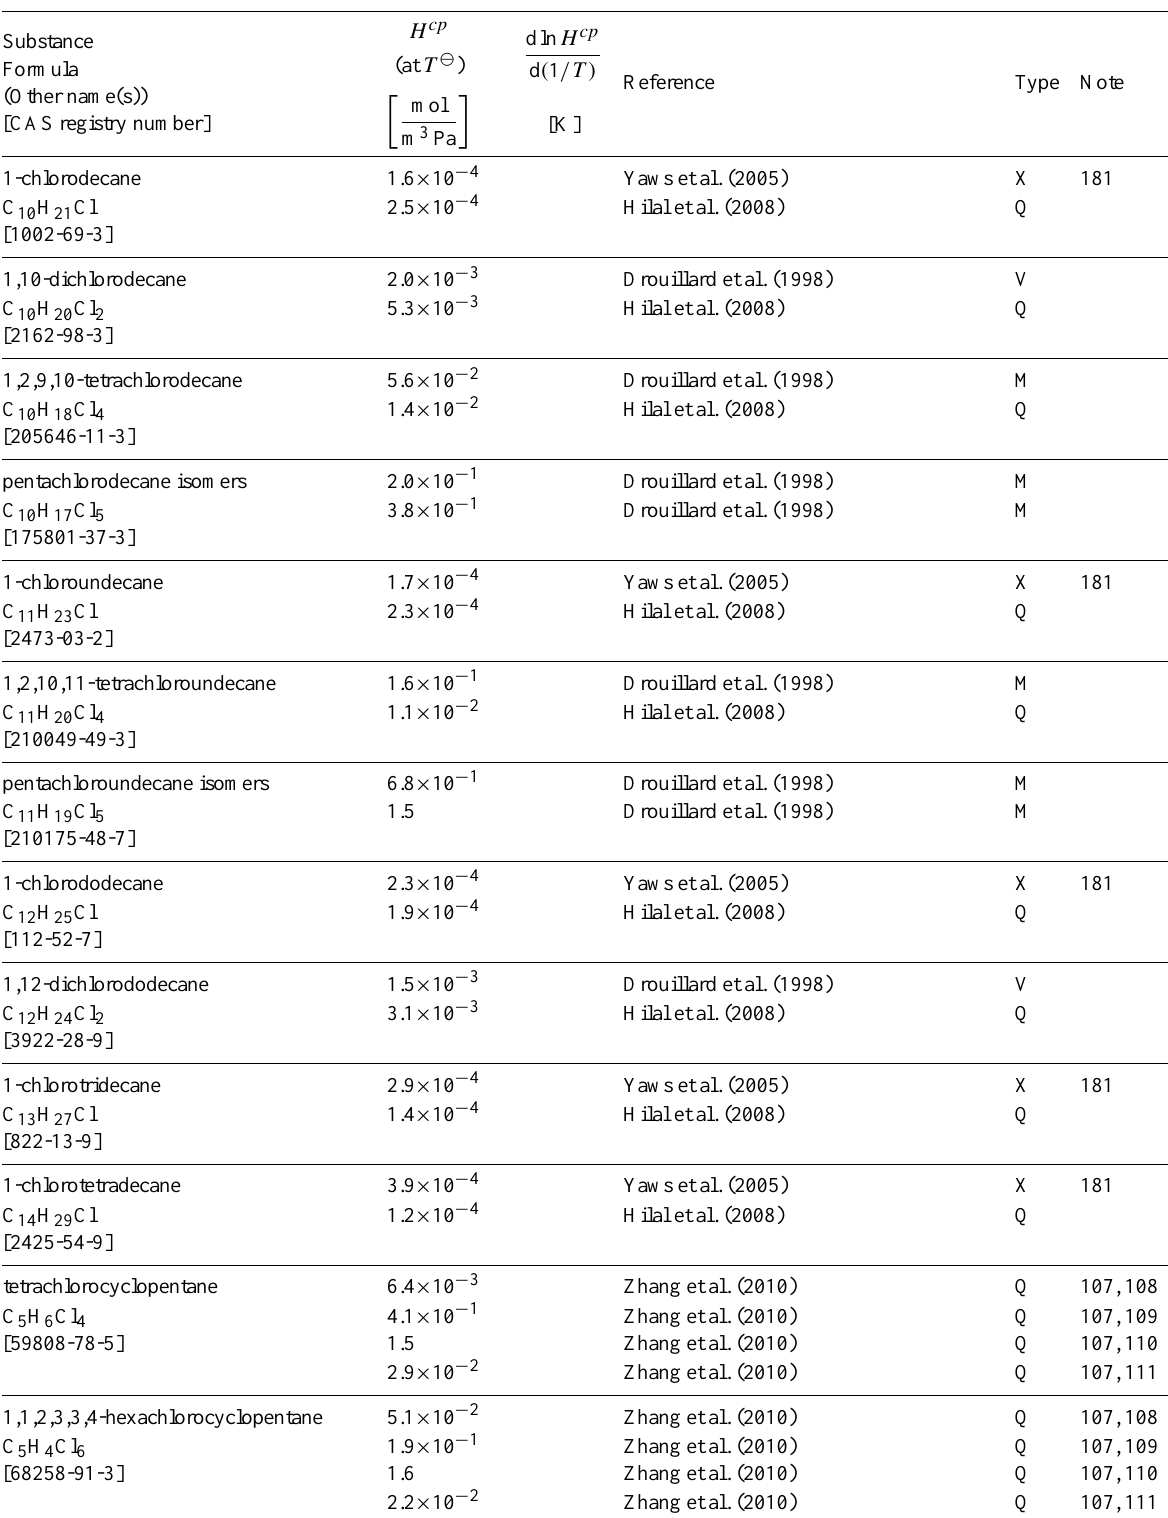
Table 6: Henry’s law constants for water as solvent